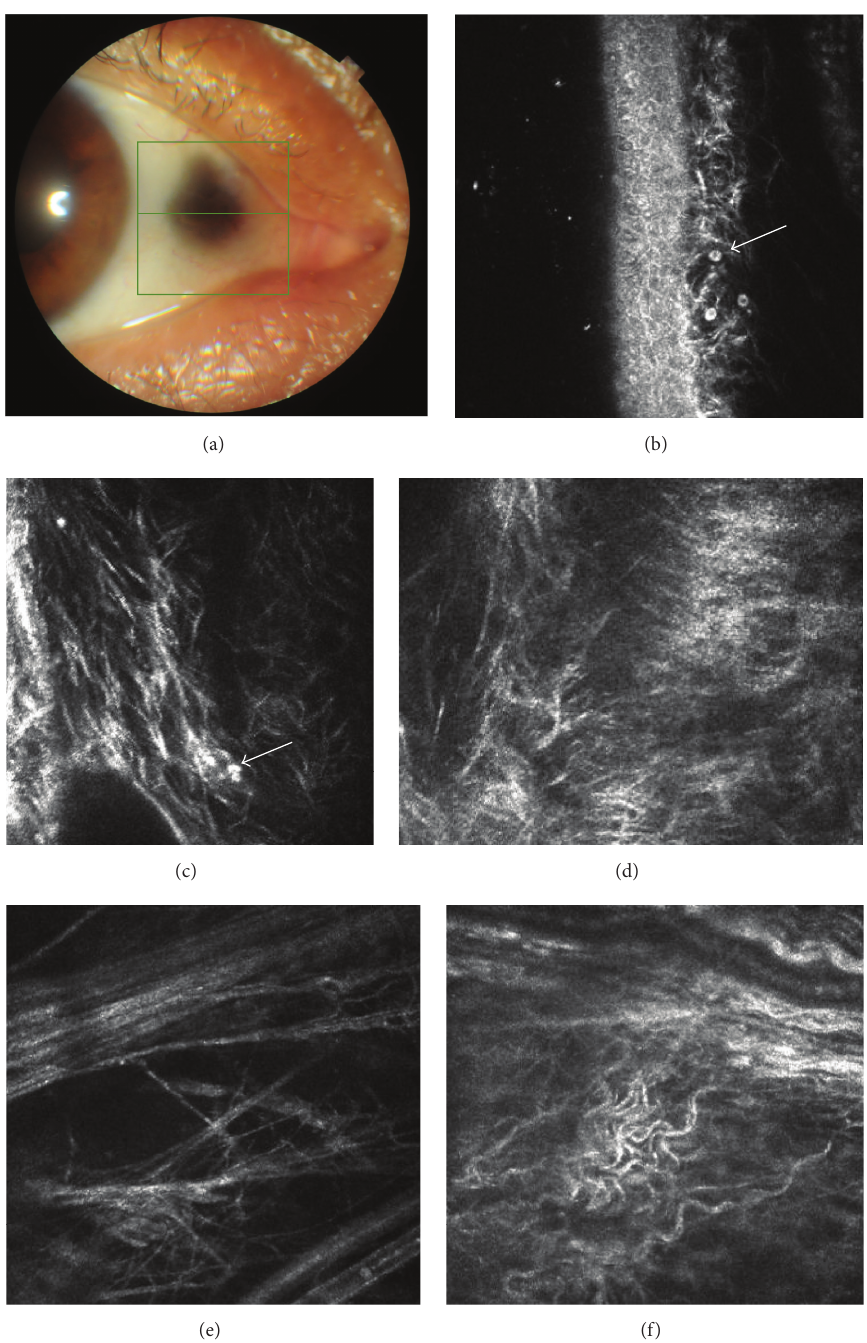
Figure 1: Anterior segment photos and in vivo confocal microscopy images of Case 1. (a) Right eye temporal conjunctiva. (b) Hyperreflective inflammatory cells beneath conjunctiva epithelium (arrow). (c) Hyperreflective deposits in the deep conjunctiva with adjacent curled collagen fibers(arrow).Anormallymphaticvesselisseenadjacenttocurledcollagenfibers.(d)Degenerativechangesinthecollagen.(e)Fragmentation of the collagen fibers and empty spaces between them. (f) Prominent curled subepithelial fibers in the deep conjunctiva. A normal lymphatic vessel is seen in the upper part of the